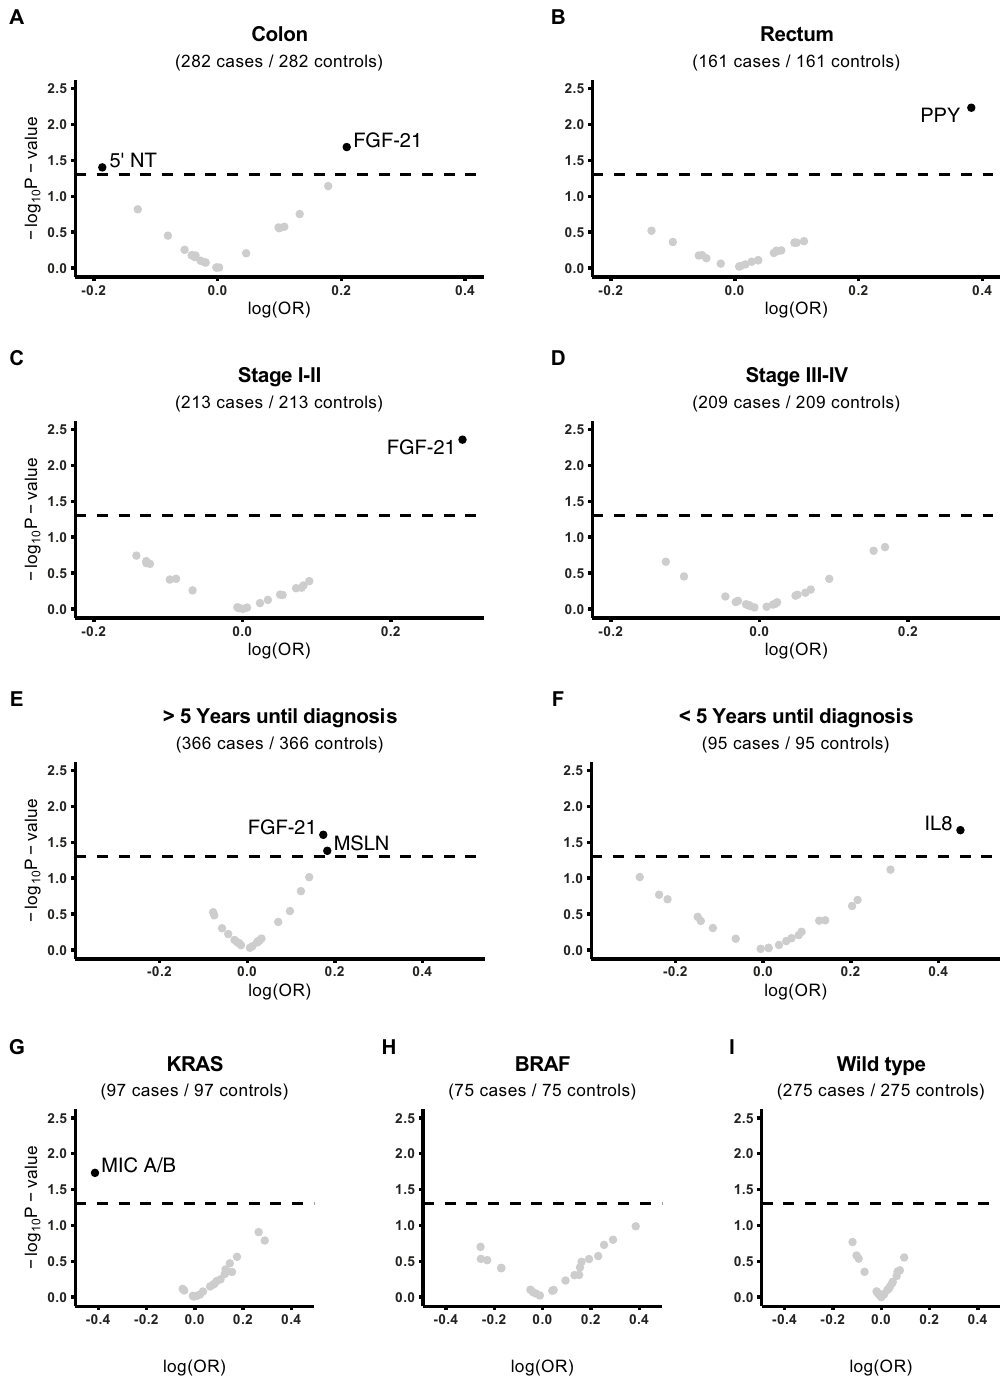
Figure 2. Volcano plots for stratified analyses comparing Colon and Rectum ( A , B ), Stage I–II and Stage III–IV ( C , D ), proximity to diagnosis ( E , F ) and molecular subtypes ( G – I ). All models were adjusted for smoking status, BMI, and level of education. The dotted line marks a p value cutoff of